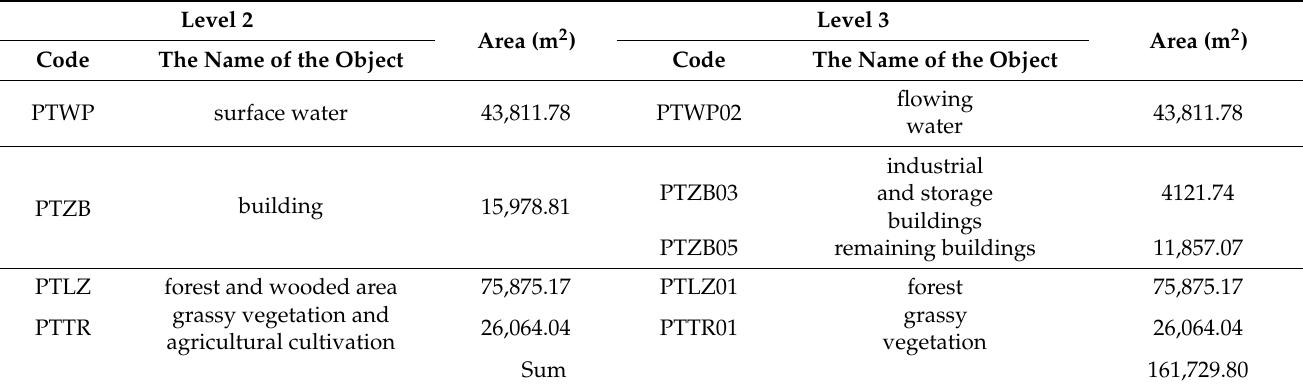
Figure 6. Visual analysis of types of land cover within the Natura 2000 Wisłouj´scie Fortress, based on BDOT10k. Source: authors’ elaboration. Table 2. Type of land cover within the Natura 2000 Wisłouj´scie Fortress based on BDOT10k. Source: authors’